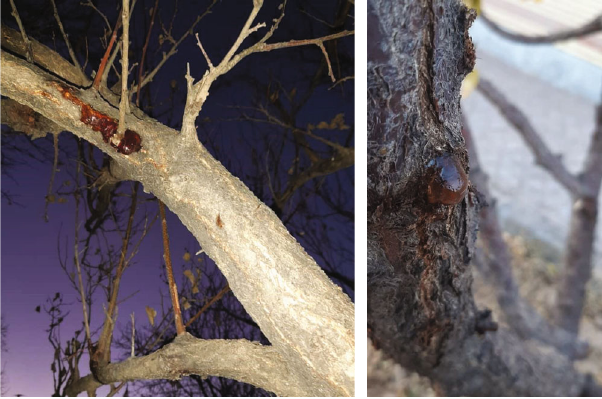
Figure 1: Tree with gum